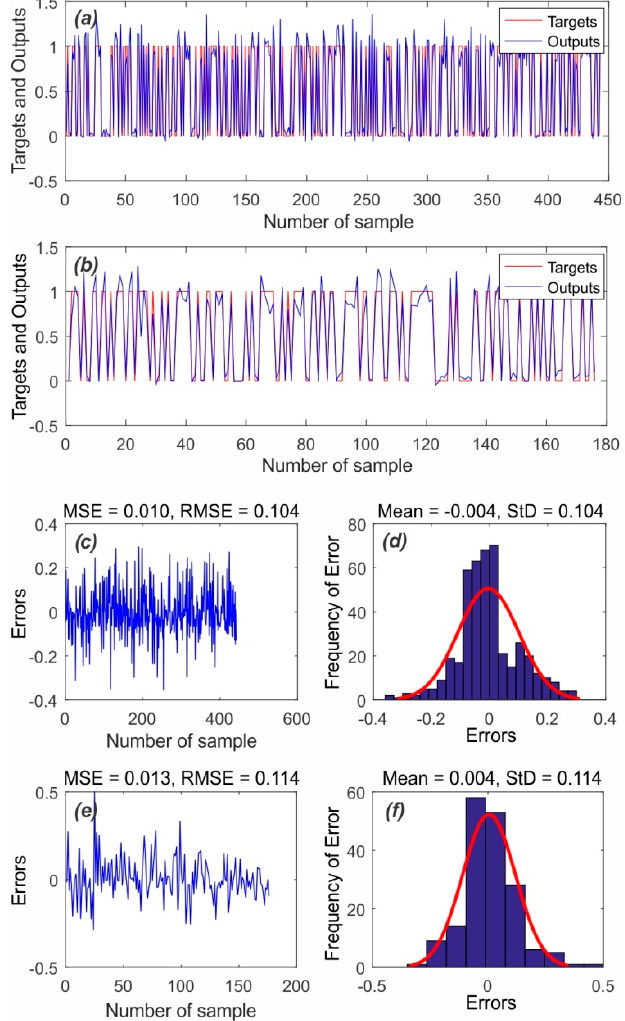
Figure 10. The SWARA-ANFIS-WOA method. ( a ) Target and outputs for the training set; ( b ) target and outputs for the verification set; ( c ) MSE and RMSE for the training set; ( d ) frequency errors for the verification set; ( e ) MSE and RMSE for the verification set; ( f ) frequency errors for the verification set.